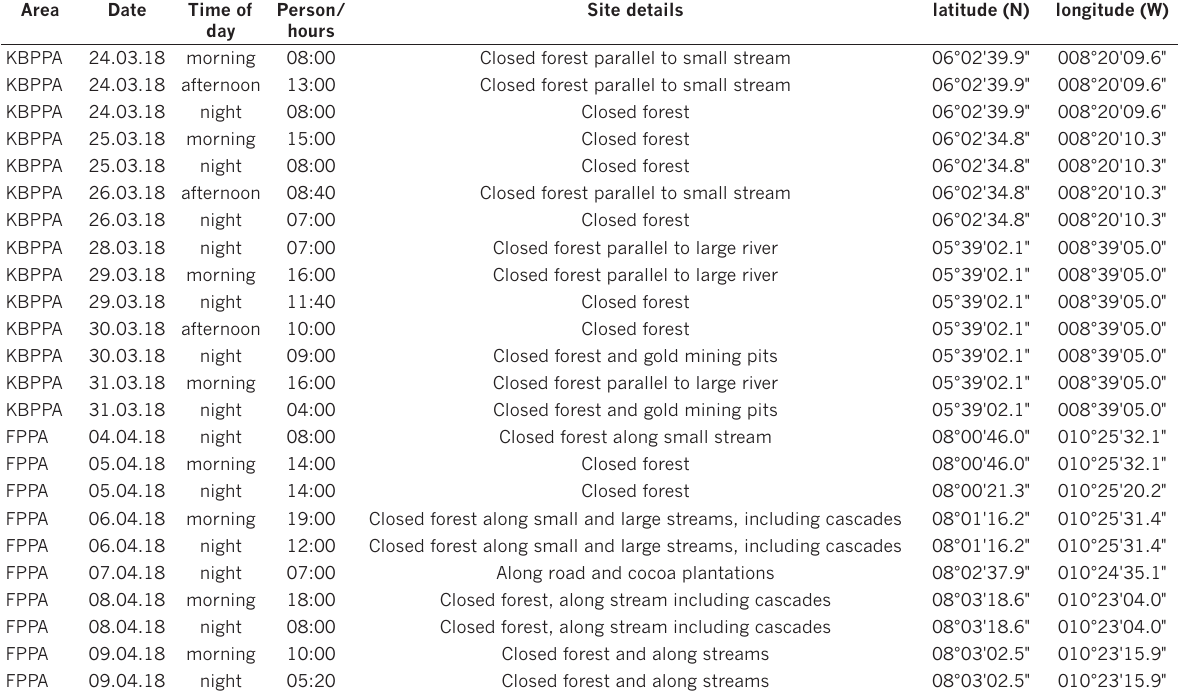
Table 1. Details on study sites in the Krahn-Bassa (KBPPA) and Foya (FPPA) herpetological survey 2018. “Person/hours” calculat- ed as time surveyed × four persons, geographic coordinates refer to initial points of survey transects.